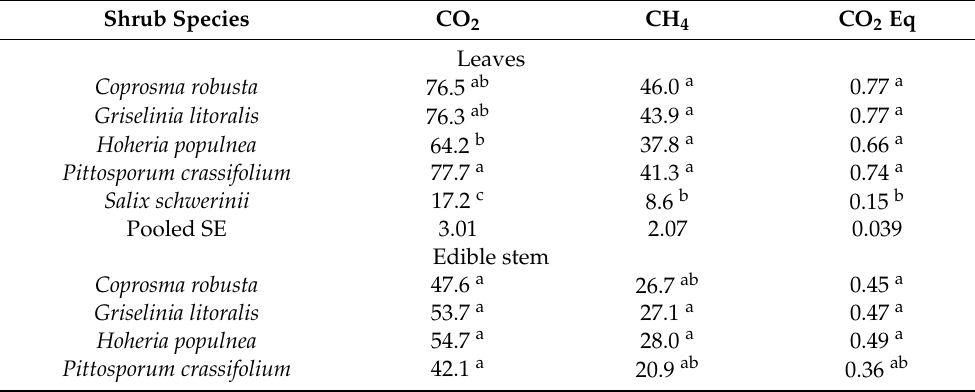
Table 10. Native shrubs ( Coprosma robusta, Griselinia litoralis, Hoheria populnea, and Pittosporum crassifolium ) and an exotic ( Salix schwerinii ) shrub species carbon dioxide (CO 2 ) and methane (CH 4 ) gas production in milliliters per gram of dry matter (mL/g DM) and greenhouse carbon-dioxide equivalent (CO 2 Eq) in grams per gram of dry matter (g/g DM) from the leaves and stems. Shrub